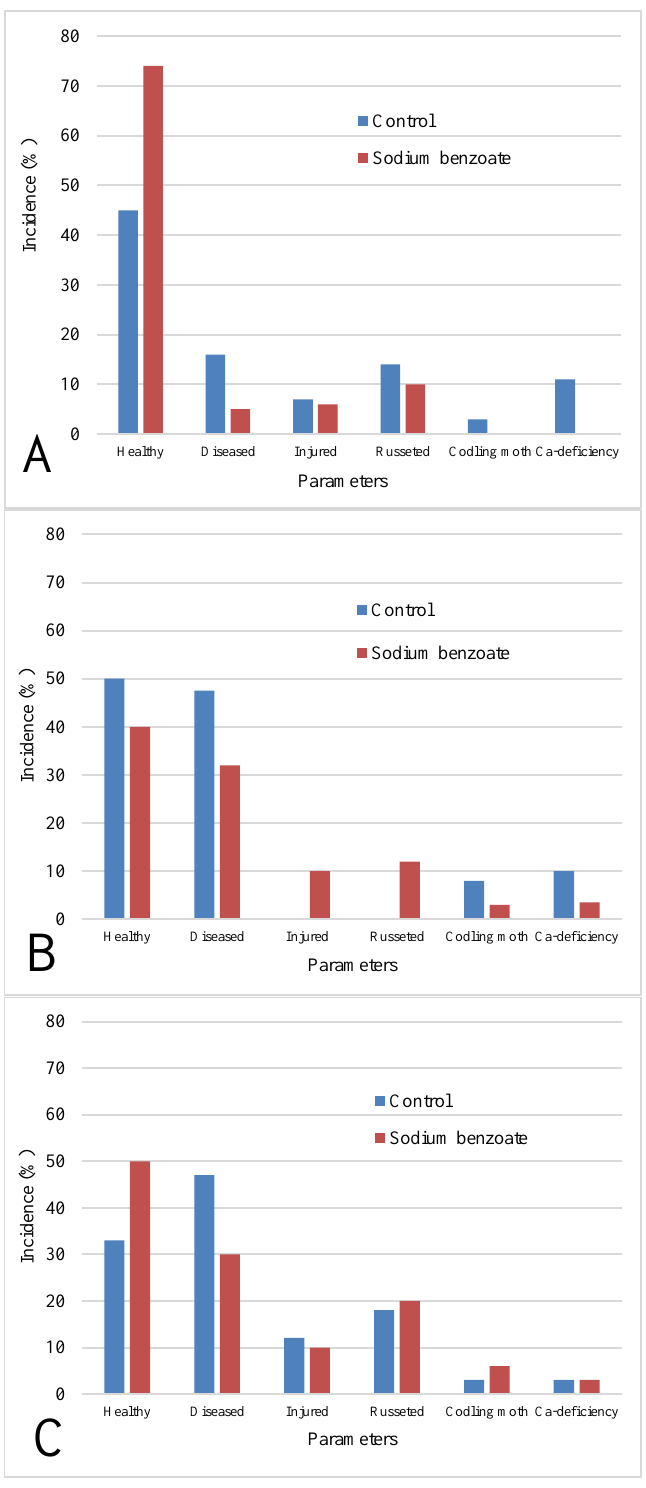
Figure 1. Incidence of selected fruit parameters of ’Topáz’ in control and sodium benzoate treatments assessed at 17 November, 2019 (A), 20 December, 2019 (B) and 23 January, 2020